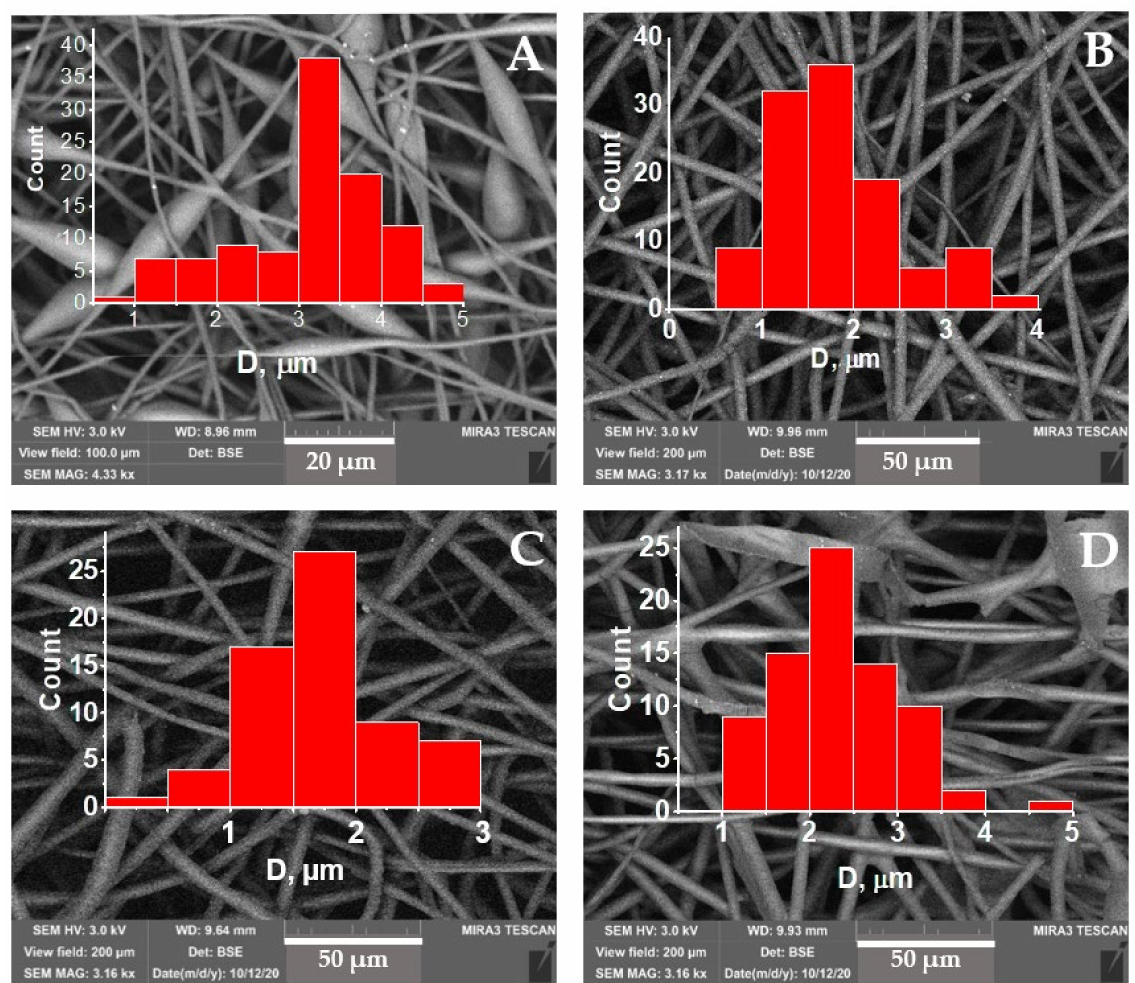
Figure 2. SEM images of the PHB fibrillar structures loaded by the metal-porhyrine complex of SnCl 2 . The concentration of SnCl 2 —PPT: ( A ) 0%, ( B ) 1%, ( C ) 3%, ( D )